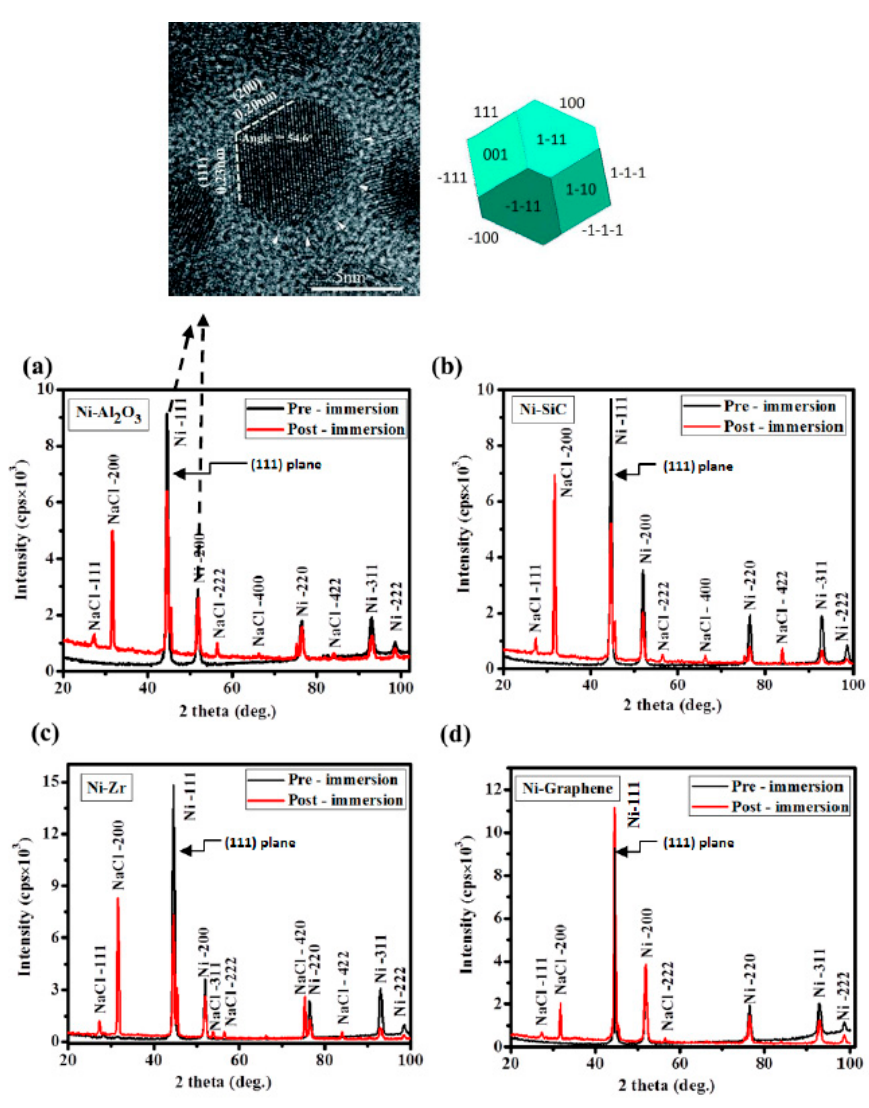
Figure 2. The XRD patterns of Ni coatings doped with ( a ) Al 2 O 3 ; ( b ) SiC; ( c ) ZrO 2 and ( d ) GPL.